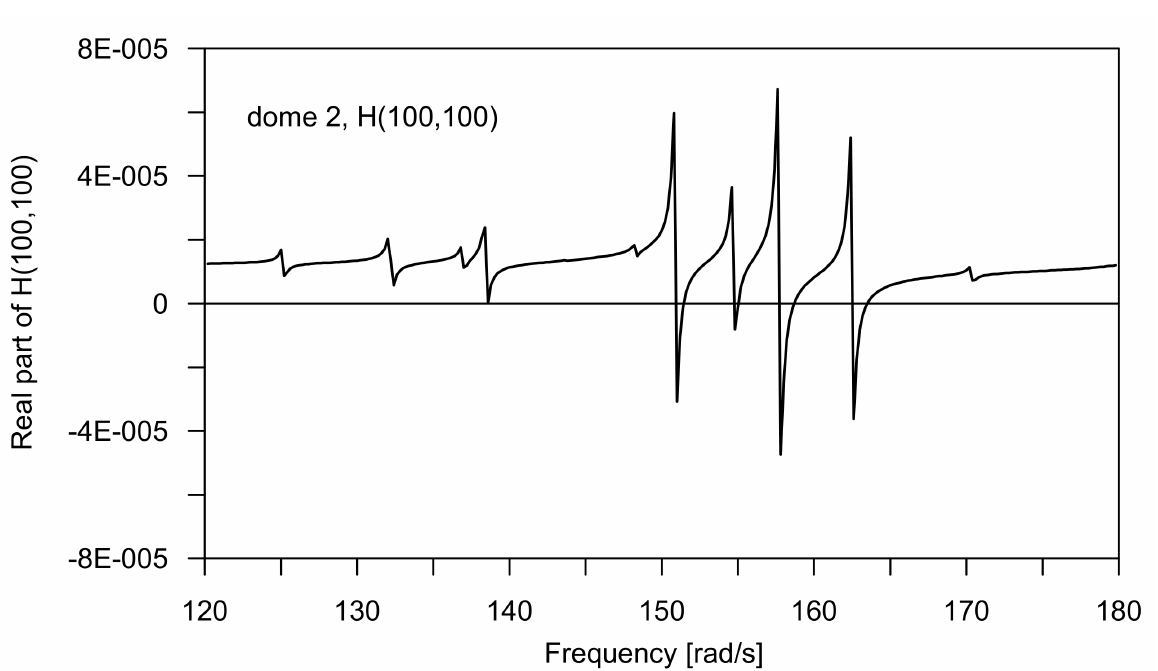
Figure 12. Representative frequency response curve.